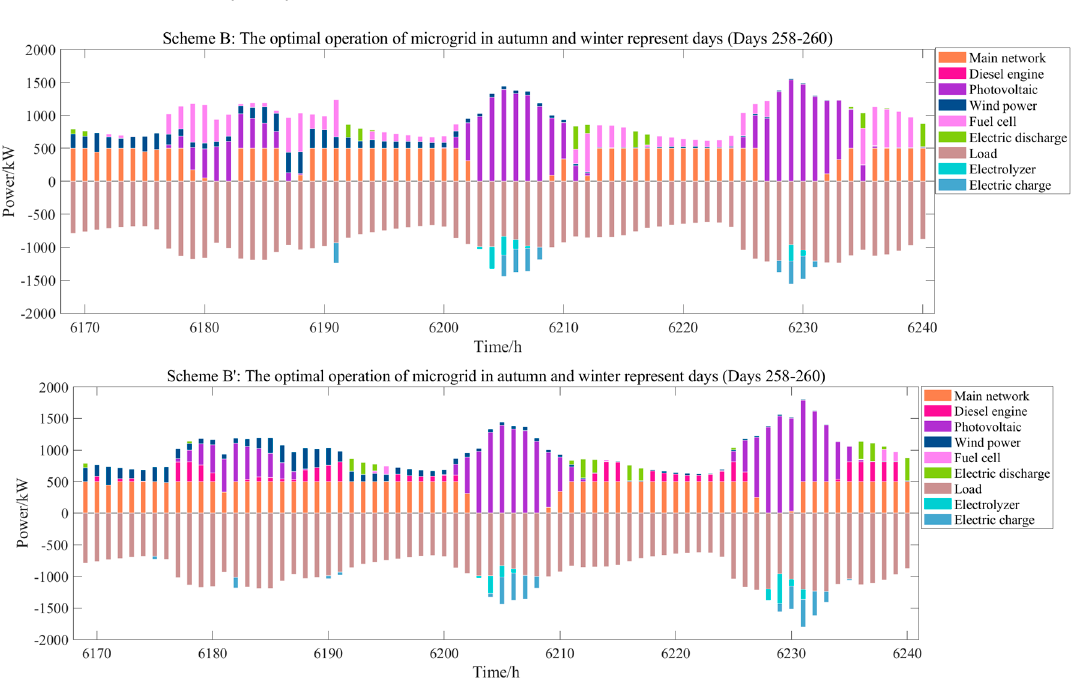
Figure 9. The optimal operation of the microgrid with two schemes in autumn and winter represents day (Days 258 − 260).